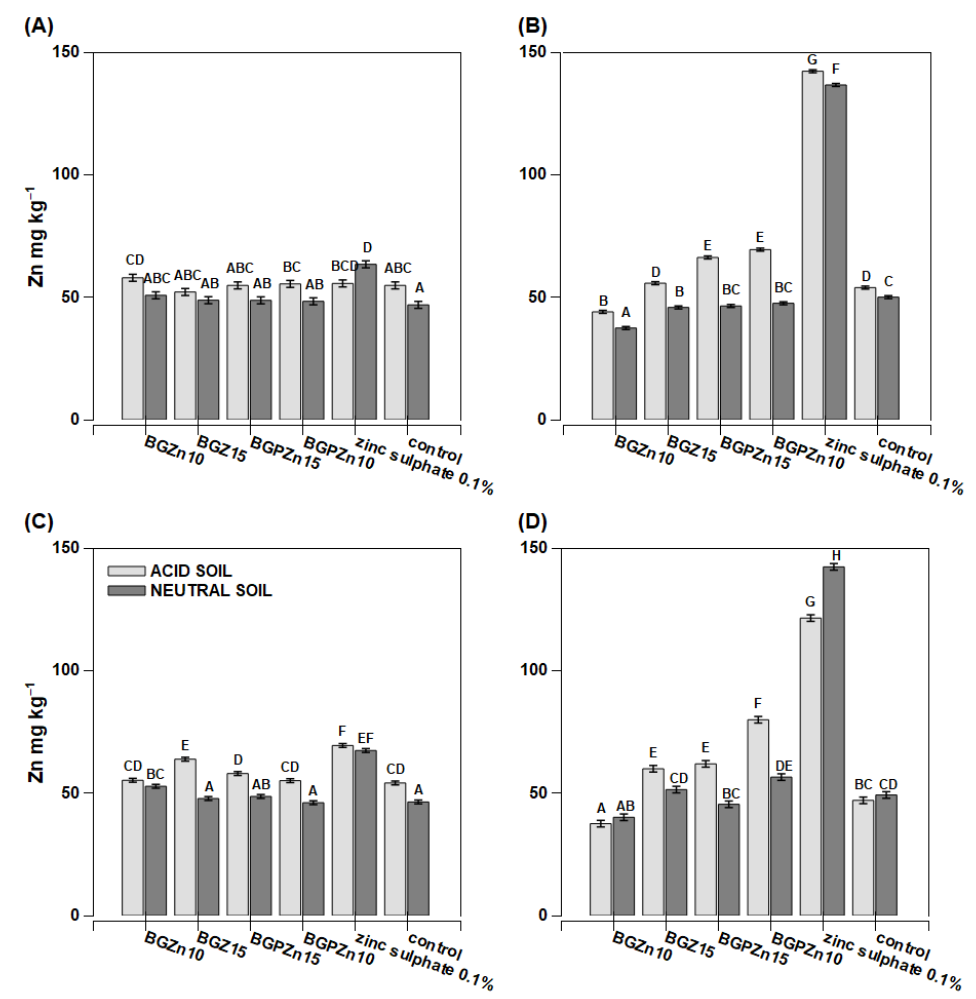
Figure 11. Zinc concentration in winter rape Brassica napus L. var napus plant parts after foliar application of fertilizer. Grey bars for acid, dark grey for neutral soil. Bars marked with the same letters represent homogenous groups after Tukey’s test at p < 0.05 and error bars represent standard error (n = 4). ( A ) In whole plant—preparation applied on one leaf; ( B ) in one leaf sprayed; ( C ) in whole plant sprayed; ( D ) in leaf cut from whole sprayed plant.